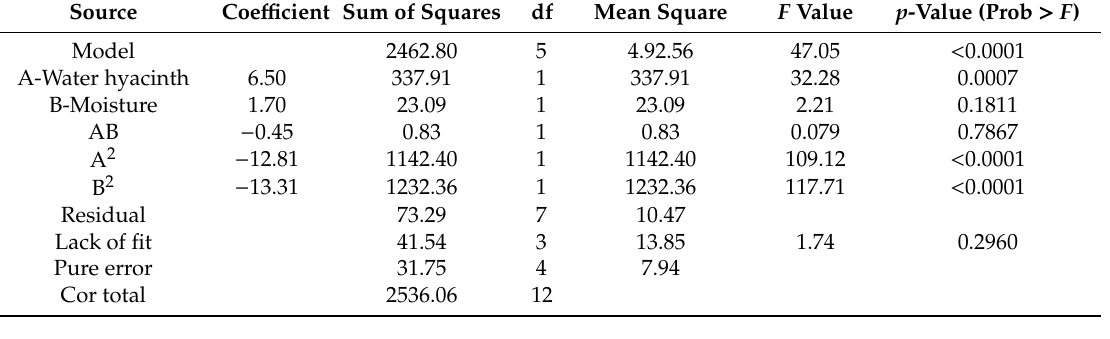
Table 5. ANOVA analysis of water hyacinth and moisture content for phytase production of P. adiposa after fitting with response surface quadratic model.